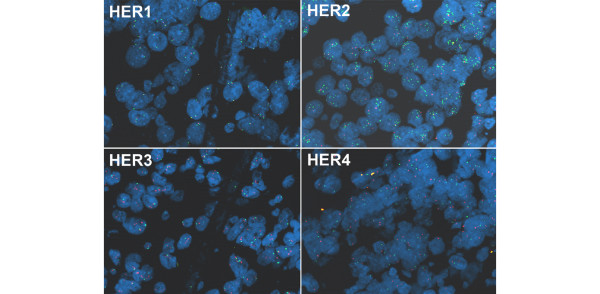
Anti-HER1–HER4 FISH in breast cancer tissue of one patient (dual probes). HER1: red cen 7, green loc 7p11 (diploid); HER2: red cen 17, green loc 17q12 (amplified); HER3: green cen 12, red loc 12q13 (moderately amplified); HER4: green cen 2, red loc 2q33 (diploid); 4',6-diamidino-2-phenylindole core staining blue. Cen, centromere; loc, gene locus.